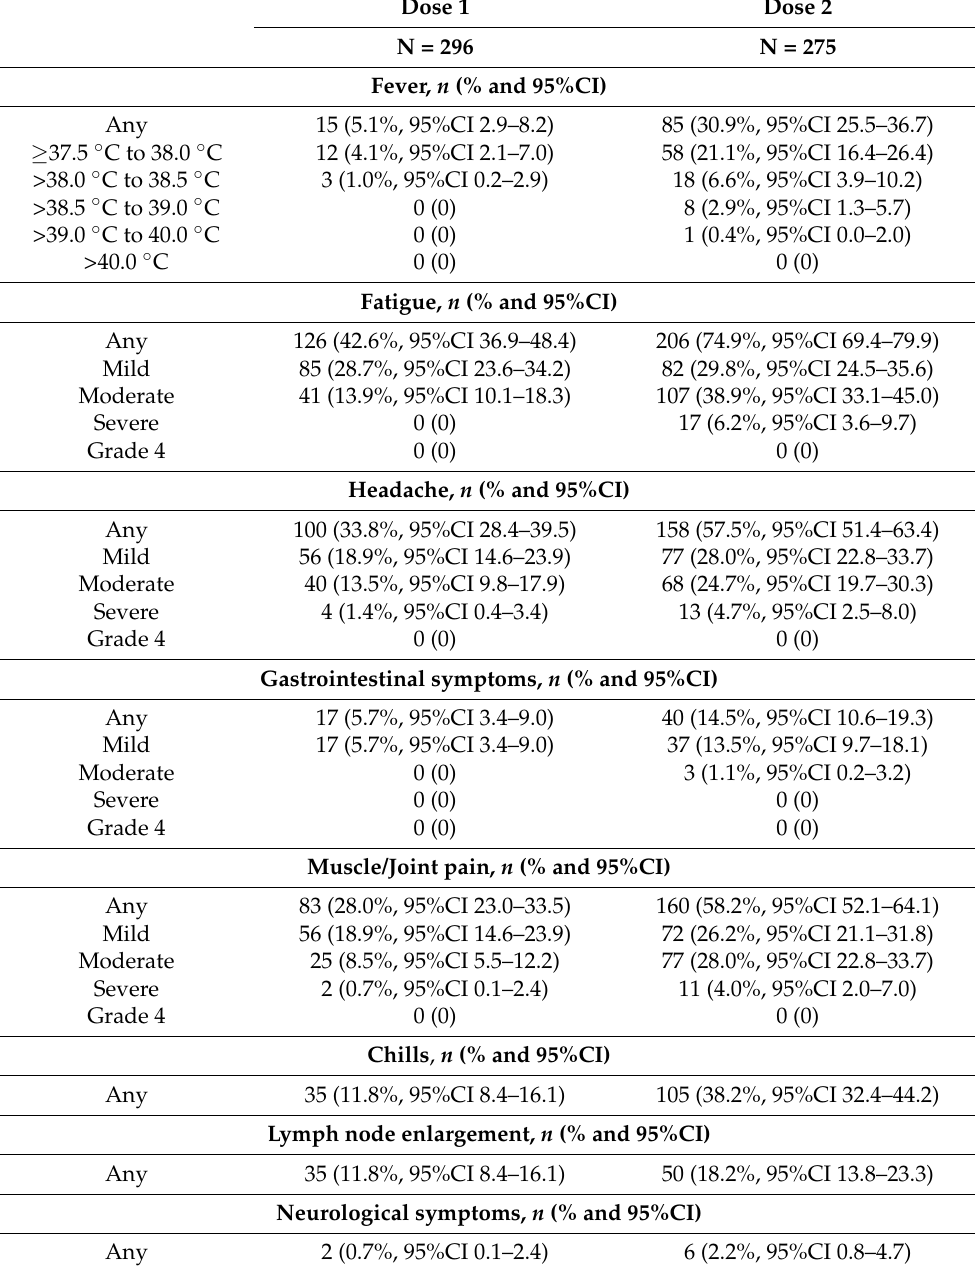
Table 3. Reporting of systemic adverse reactions in the 7 days after the first and second vaccine dose administration, stratified by symptom